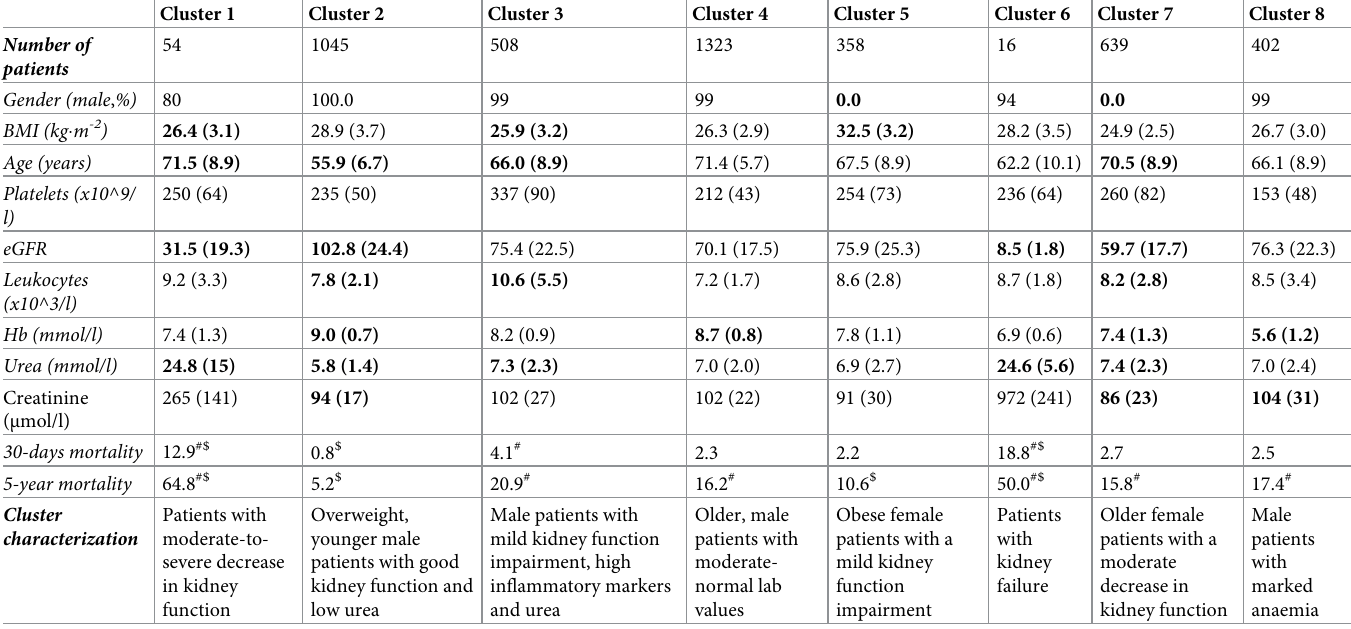
Table 3. Patient characteristics and preoperative factors based on putative pre-cooling cluster membership for 4351